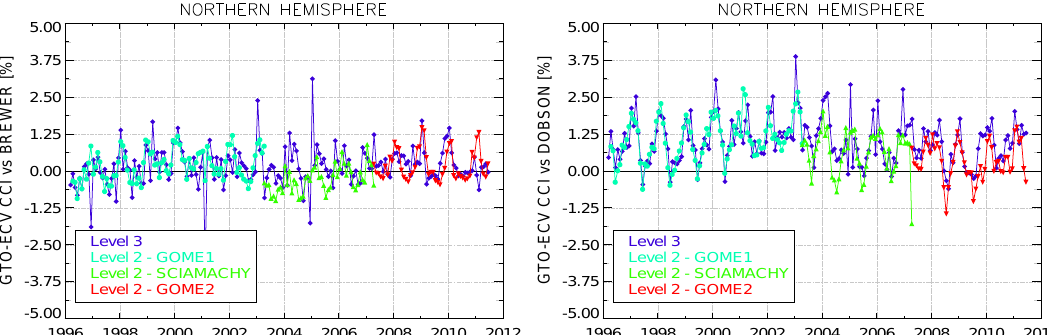
Figure 9. Percentage difference between satellite data records and ground-based data as a function time for the Northern Hemisphere. Left: Brewer comparisons and right: Dobson comparisons. Level 3 comparison in dark blue, GOME level 2 comparison in light blue, SCIAMACHY in green, and GOME-2A in